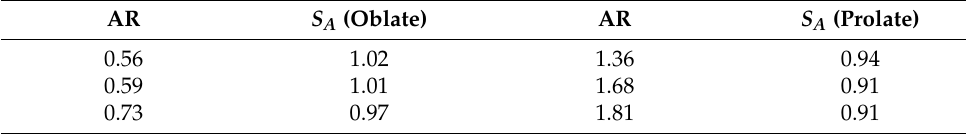
Table 2. Calculated S A for various ARs.